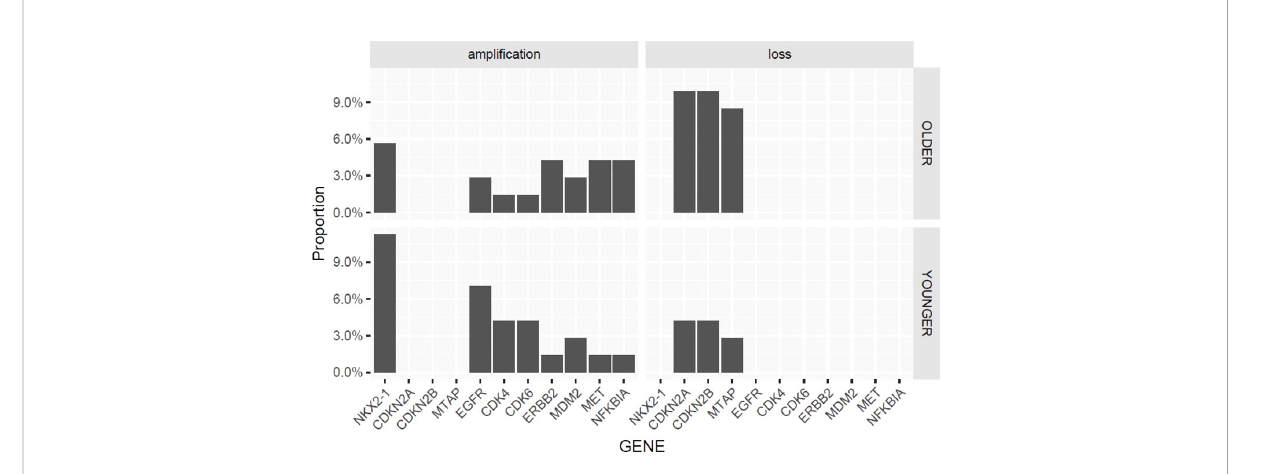
FIGURE 5 Copy number variation in older vs younger